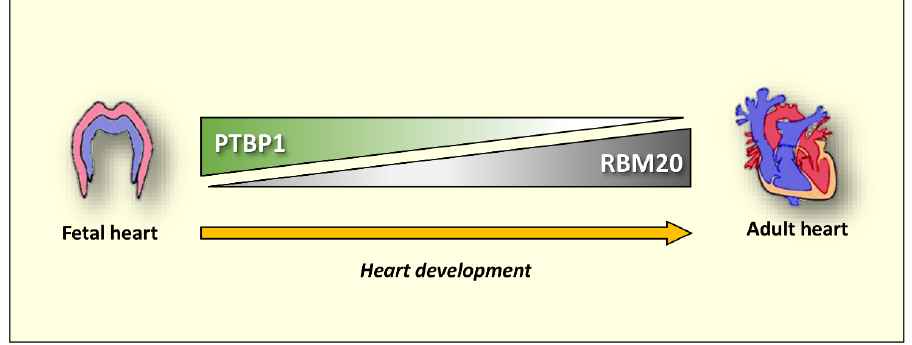
Figure 3. Schematic representation of RBM20 and PTBP1 temporal expression during heart development.